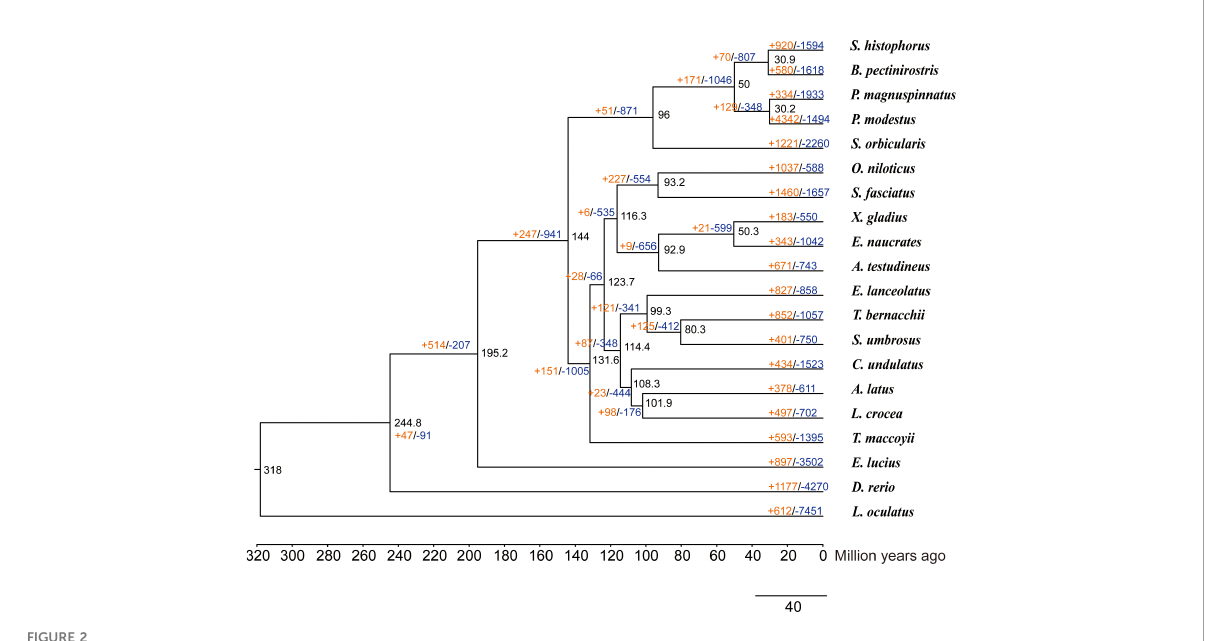
FIGURE 2 Phylogenetic tree of Scartelaos histophorus with 19 other species. Black numbers at nodes represent divergence time. The orange numbers and blue numbers represent the numbers of expanded and contracted gene families,